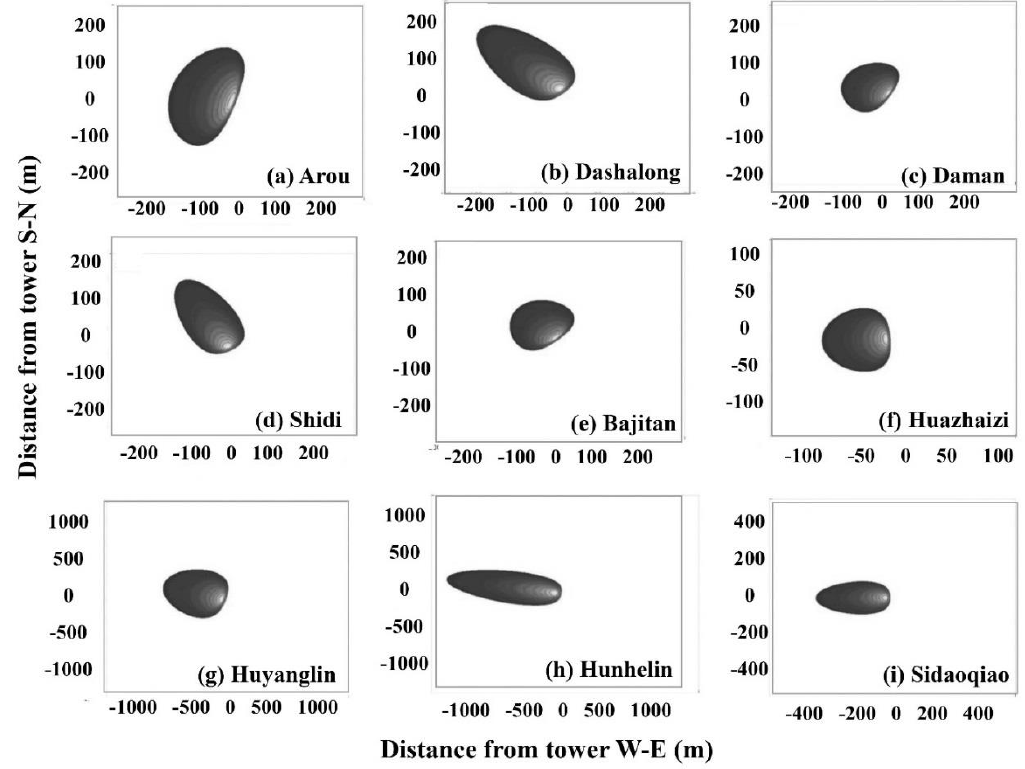
Figure 4. Real-time footprint of field GPP. The footprint displayed in this figure is from 24 July 2014. The gray level describes the contribution rate of the source area.